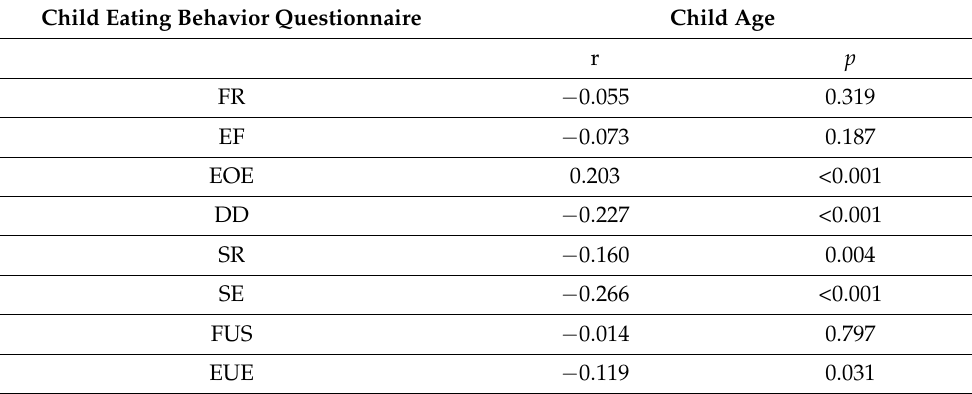
Table 2. Pearson correlations between child appetitive traits assessed with the Child Eating Behavior Questionnaire and child